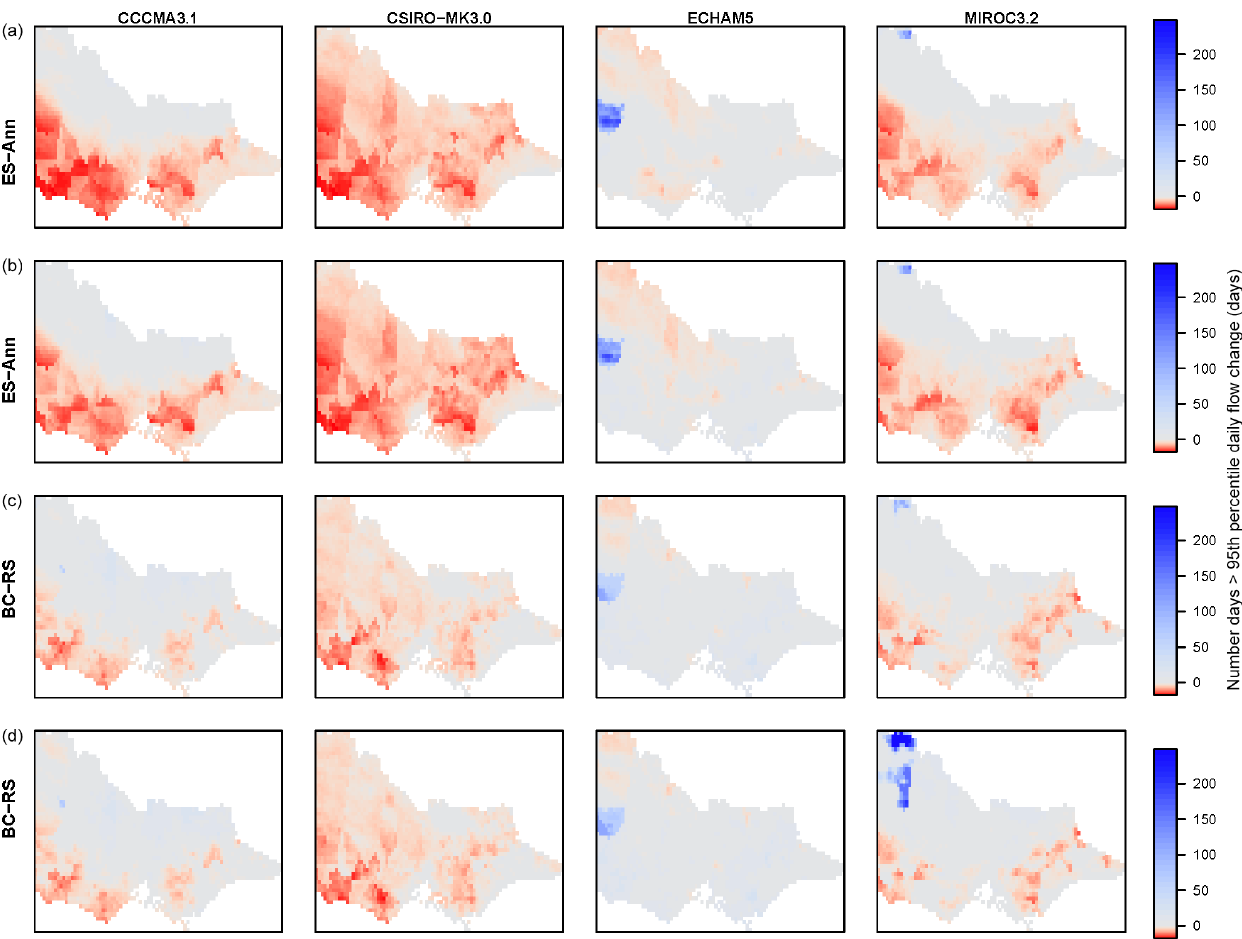
Figure 7. Change in number of days exceeding historical 95th-percentile daily flow (future minus historical) for (a) ES-ann, (b) ES-seaann, (c) BC RS and (d) BC. Columns (left to right) show CCCMA3.1, CSIRO-MK3.0, ECHAM5 and